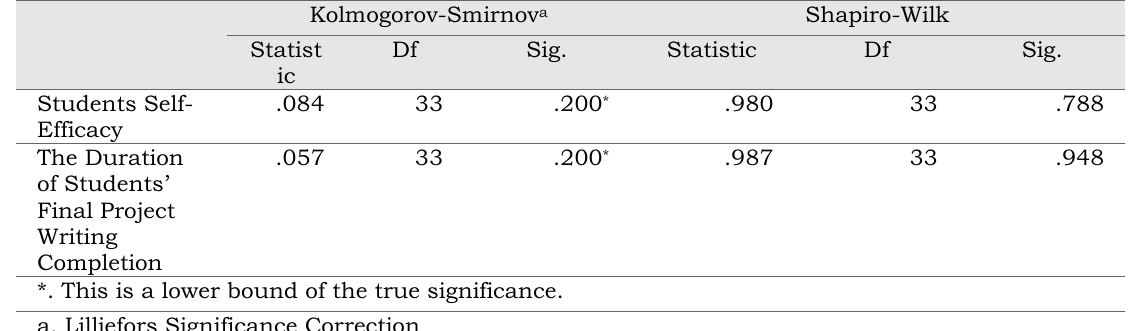
Table 4. Tests of